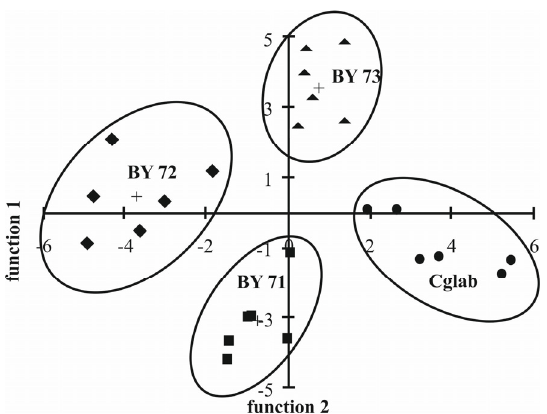
Figure 1. Values of two discriminant scores (discriminant analysis) for the 24 yeast samples for 34 principal ions, which were selected to discriminate between S. cerevisiae (haploid strains BY4741 and BY4742) (BY71 and BY72), S. cerevisiae diploid strain BY4743 (BY73), and C. glabrata (Cglab). S. cerevisiae (haploid strain BY4741) group; +. group centroids. Figure reprinted with permission from [48]. Copyright 2005, American Chemical Society.